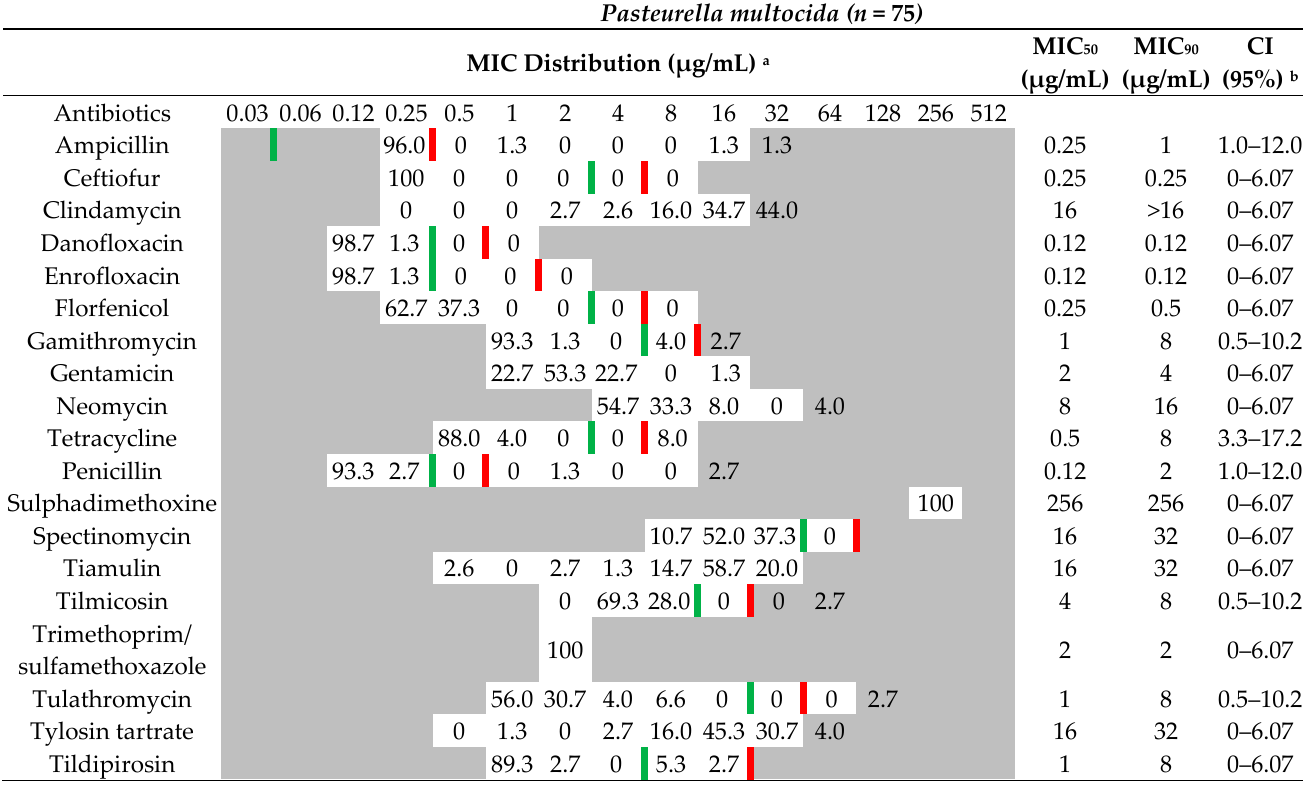
Table 5. MIC distribution frequencies of P. multocida cattle isolates from Australia 2014–2018.